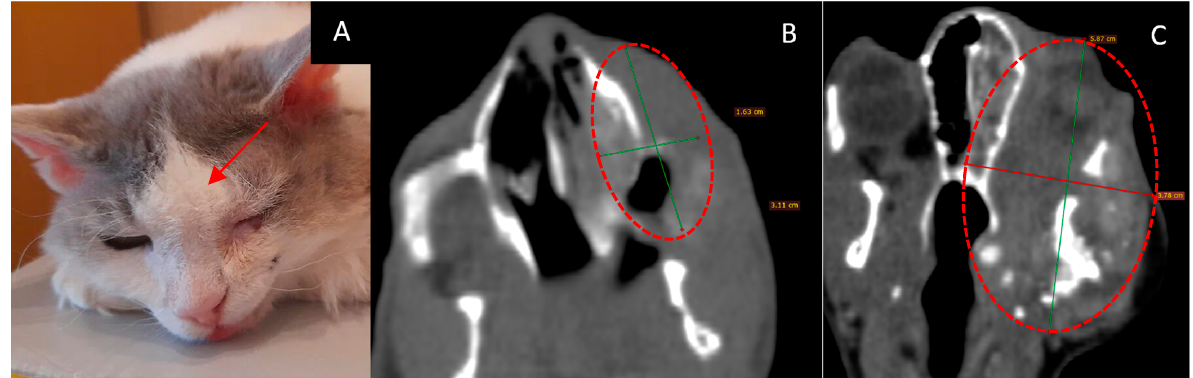
Figure 6. Female cat “Marusya” (10 years old) with squamous cell carcinoma in the upper jaw on the left side with invasion into the nasal cavity and left orbital space and destruction of the upper jawbone. Animal appearance before irradiation ( A ) with the outer tumor mass (arrow). Head CT ( B ) before irradiation showed a tumor 16 × 31 mm in size (green lines, dashed red circle). Head CT after the treatment ( C ) showed that the tumor had increased in size to 38 × 59 mm (green and red lines, dashed red circle).